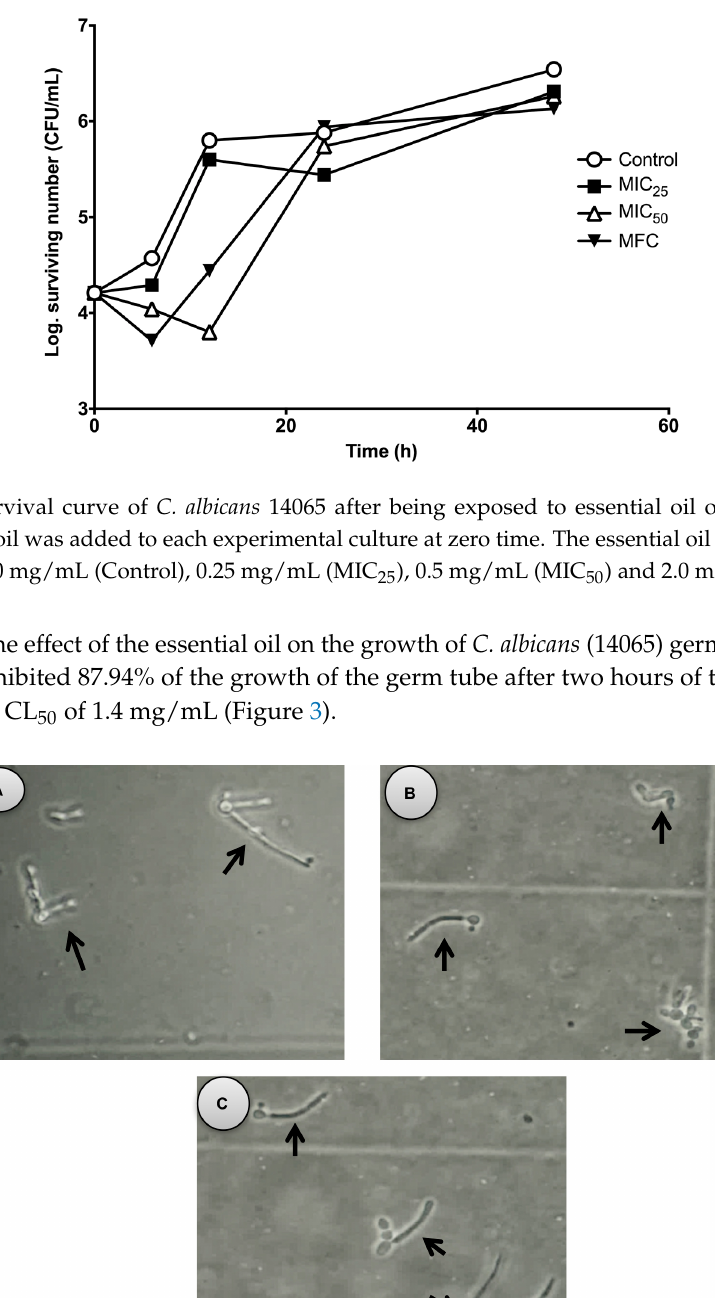
Figure 3. Effect of essential oil from B. morelensis concentration on germ tube growth of C. albicans 14065. Black line: experimental data; red dotted line: predicted values. The cellular wall of the yeasts of the control tube show a strong blue showing the presence of chitin contained in the cell wall (Figure 4A,B); the cell membrane is intact and the propidium iodide is excluded from viable cells (Figure 4C), since the dye did not access DNA. Nevertheless, 10 mg/mL of the essential oil caused the loss of the integrity of the cell membrane, the propidium iodide easily penetrate the damaged permeable membranes of non-viable cells, and there was a binding of propidium iodide to DNA (Figure 4E,F), which shows the damage in the cellular membrane of C. albicans by the essential oil of B. morelensis .